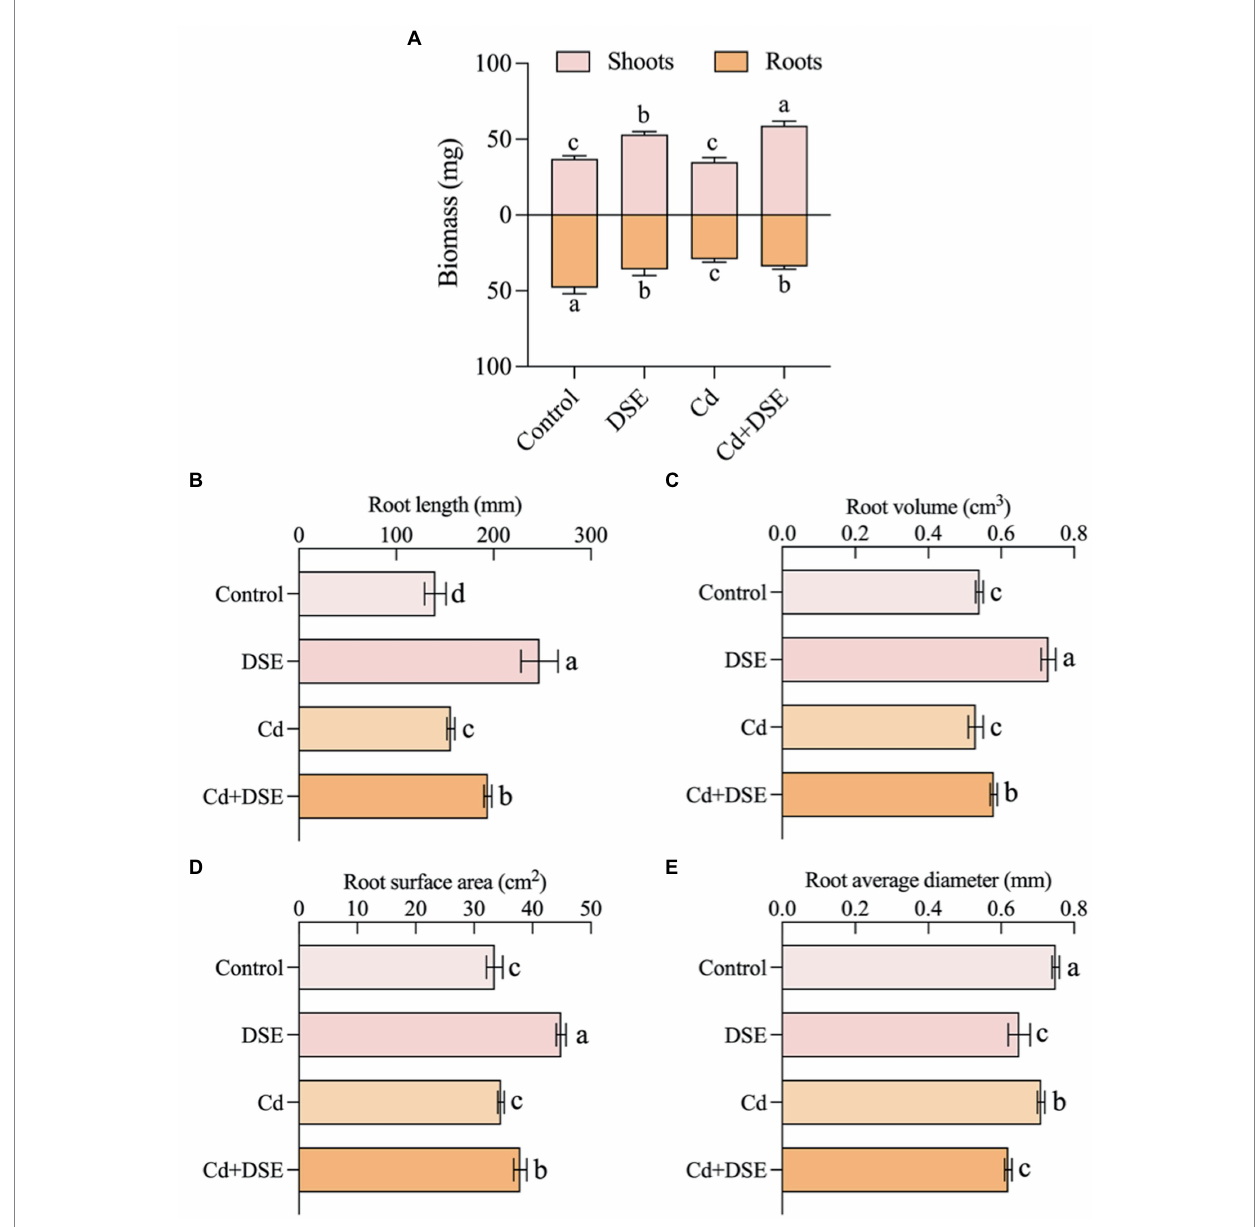
FIGURE 1 Responses of shoots and roots biomass (A) and morphological traits, including root length (B) , root volume (C) , root surface area (D) and root average diameter (E) of maize to E. pisciphila inoculation and Cd stress. Data were mean values ( n = 3) and error bars represent the standard deviation. Different letters indicate significant differences between